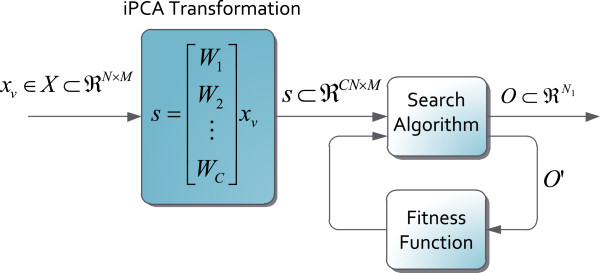
Optimization scheme used in the parameter configuration stage. Wi is a PCA matrix transformation of size N × N for i = 1,…,C. Note that each Wc (for c = 1,2,…C) matrix has a N × N size, then the projected vector s has an incremental size of CN × M.